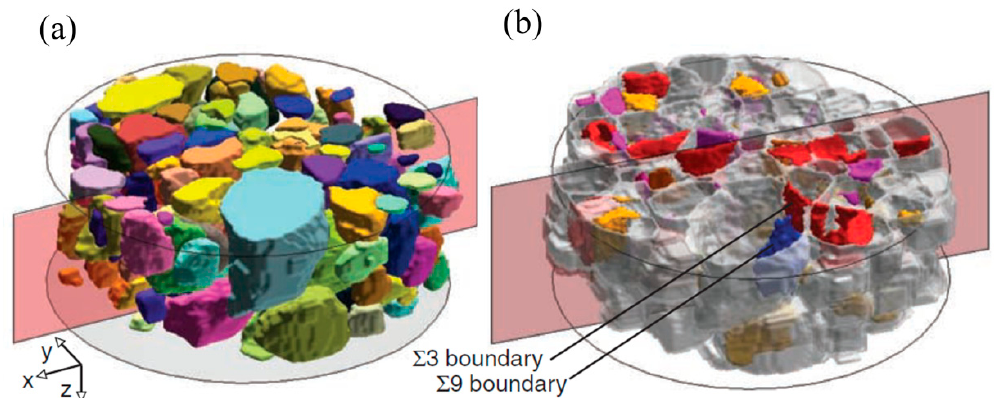
Figure 12. The 3D grain map of austenitic stainless steel obtained by DCT, including 169 grains (a total of 362 grains were measured) [54]: ( a ) grain crystallographic orientation using an RBG scale; and ( b ) grain boundaries using colors. Different colors represent the different coincident site lattice (CSL).